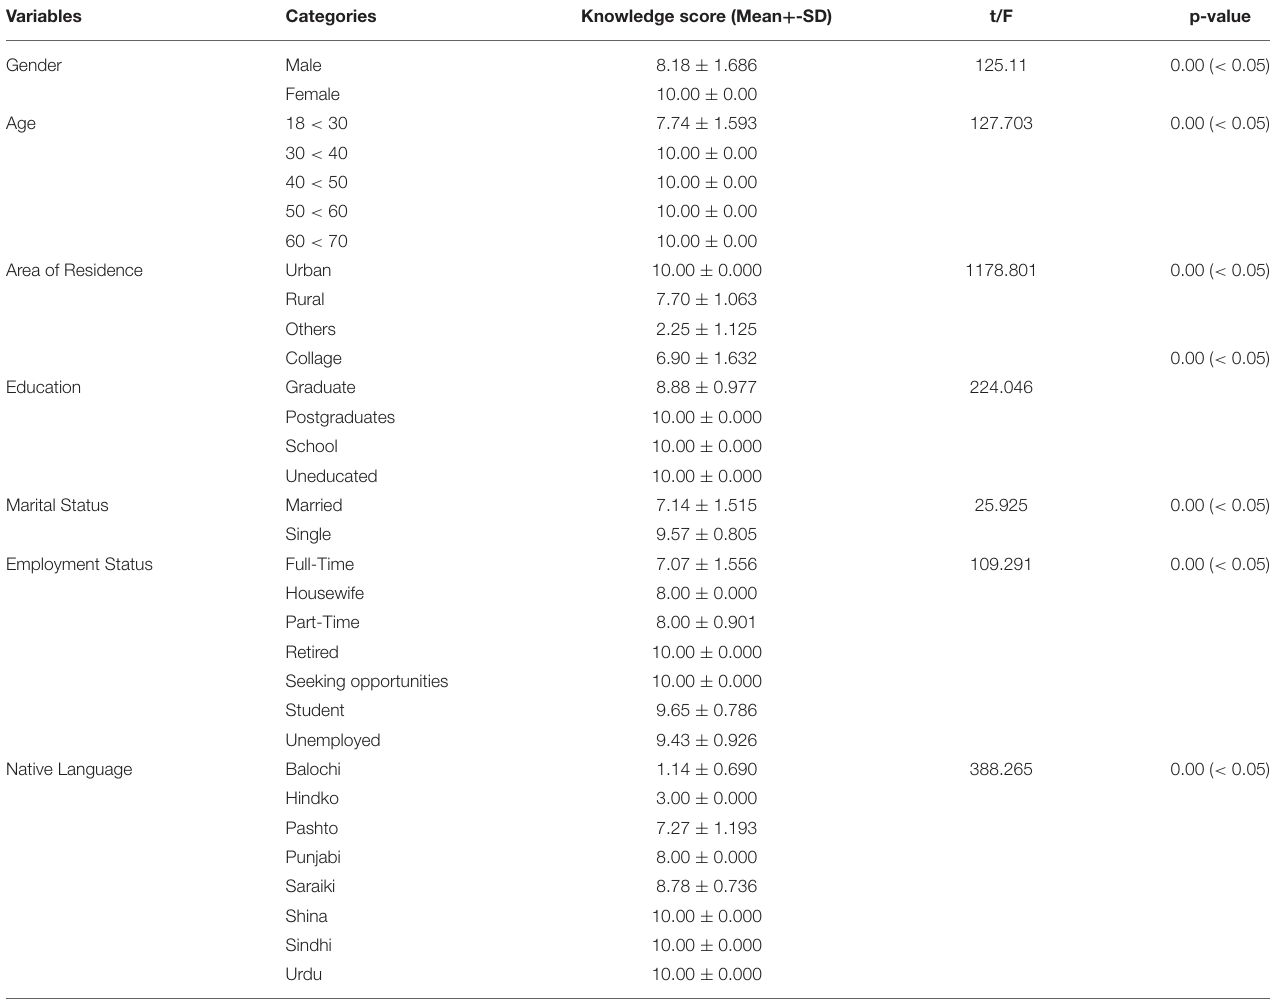
TABLE 3 | Association of knowledge with demographic variables of respondents ( N = 734).